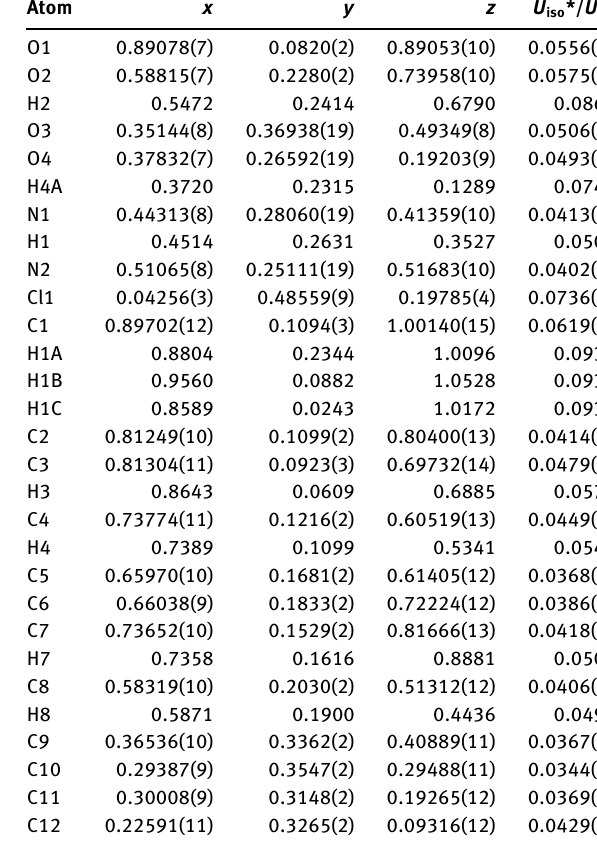
Table 2: Fractional atomic coordinates and isotropic or equivalent isotropic displacement parameters (Å 2